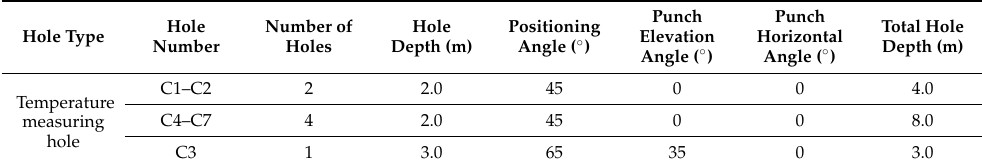
Table 6. List of temperature measuring hole drilling characteristics.